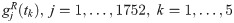
5 points based subclustering.Clustering based on centered expression values gjR(tk),j=1,…,1752,k=1,…,5. n
genes—number of genes in each cluster and n
TF—number of Transcription Factors in each cluster.